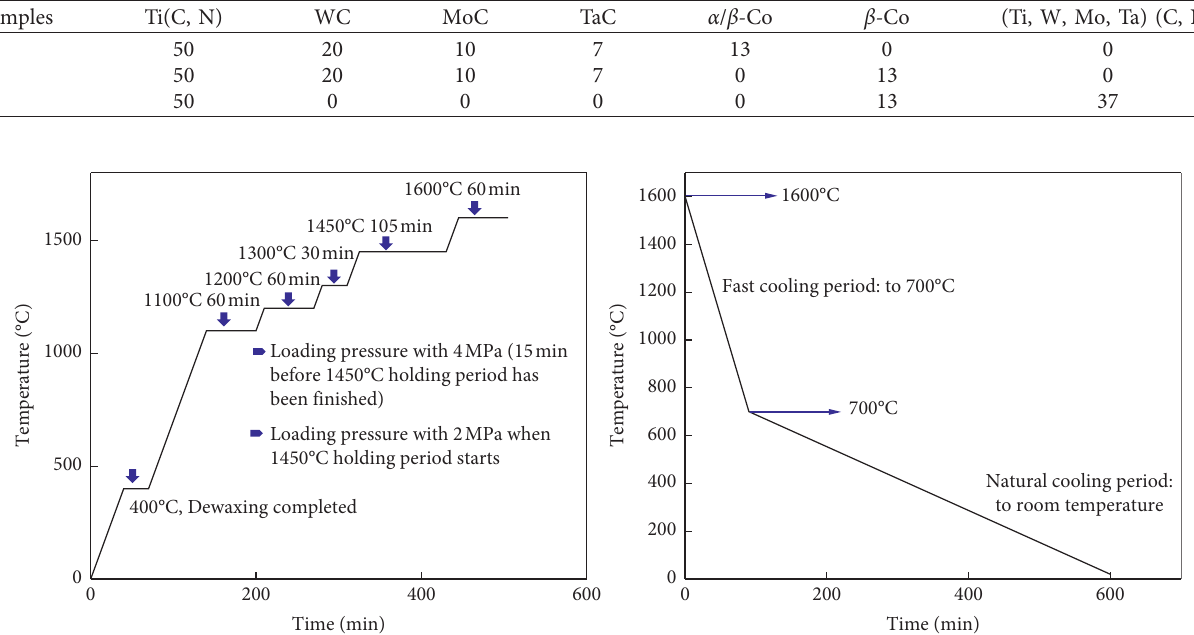
Figure 1: Curve of cermet sintering process.